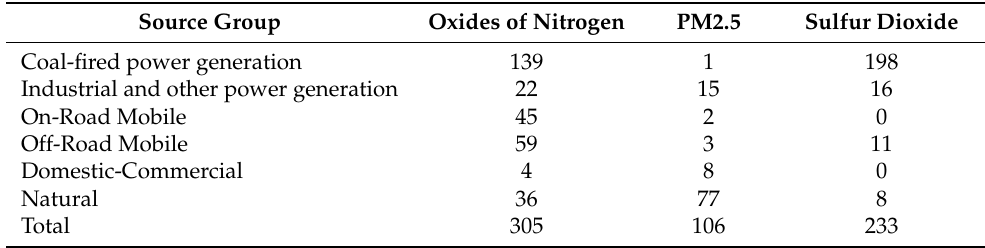
Table 1. Source contributions to NSW Greater Metropolitan Region emissions (2013, kilotons per an- num).